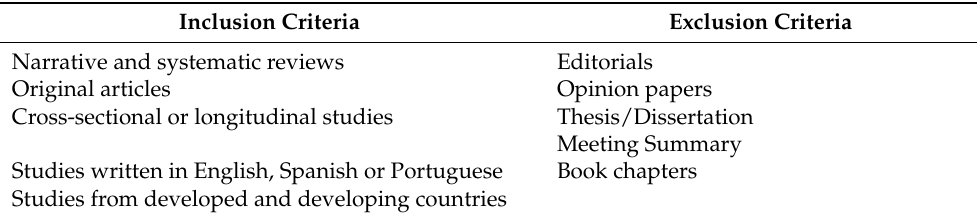
Table 1. Study inclusion and exclusion criteria adopted for the selection of